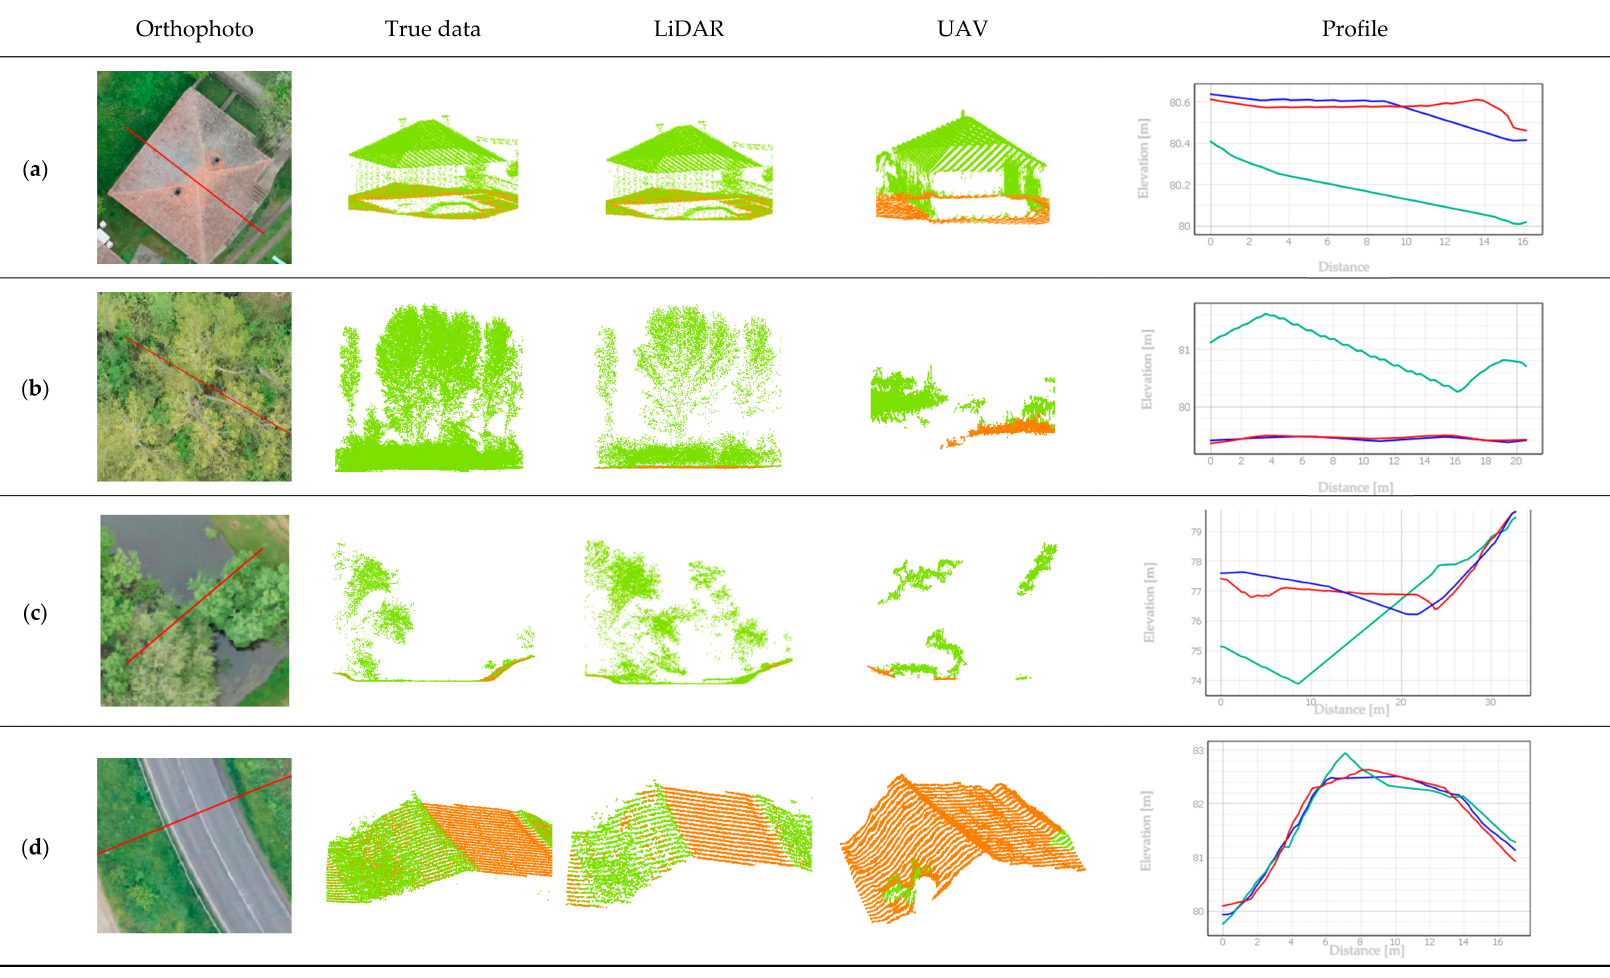
Figure 3. Comparison true data and LiDAR and UAV data using the proposed classification method. The green points represent the non-ground class, while the orange points represent the ground class. Profiles were created over di ff erent land cover classes (( a ) built up areas; ( b ) dense vegetation; ( c ) water; ( d ) bare earth) based on DEM with a spatial resolution of 25 cm. The red, blue, and green lines represent the true, LiDAR, and UAV data,